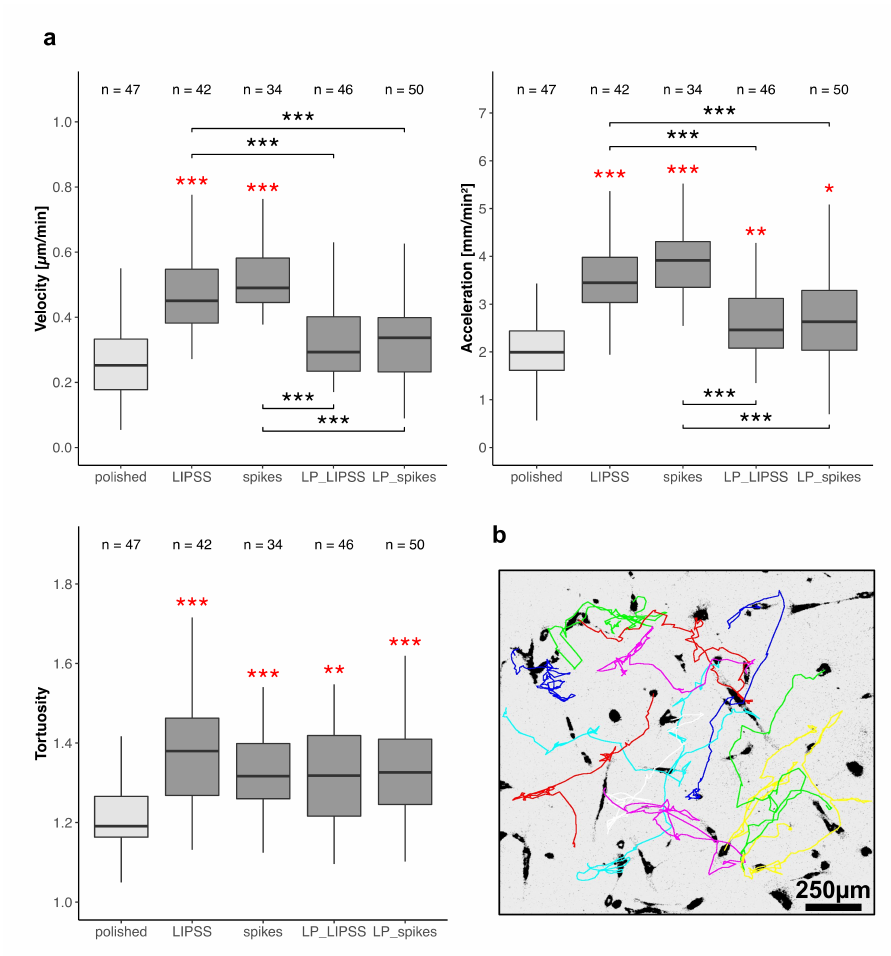
Figure 4. Cell motility on polished and laser-treated surfaces. hMSCs were observed 1 h post-seeding for 63 h and every 30 min on sterilized Ti6Al4V samples. ( a ) Mean velocity and acceleration (absolute value) were measured for each cell individually. Mean tortuosity was defined as the ratio between the accumulated distance and the Euclidean distance every 1.5 h and averaged on the whole record for each cell. Three areas per sample were analyzed, the exact number of analyzed cells is indicated above each boxplot. The Kruskal–Wallis test followed by Mann–Whitney pairwise comparison with Bonferroni correction was performed on data. * p -value < 0.05, ** p -value < 0.01, *** p -value < 0.001 Red asterisks denote significant di ff erences versus polished surface. ( b ) Representative migration trajectories of cells on spikes by manual tracking of